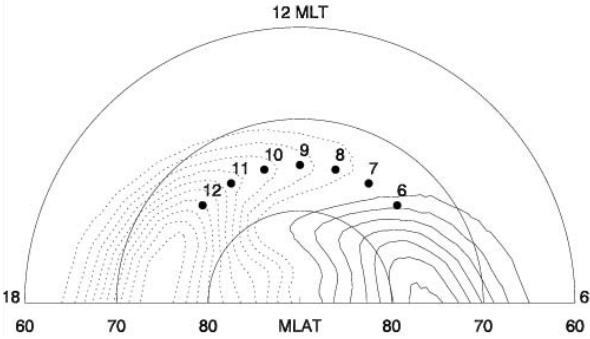
Fig. 3. High latitude electric potential calculated by using the Heppner-Maynard electric convection field model in the condition that IMF By and Bz are negative. The locations of the ESR site during 06:00–12:00 UT are marked by circle dots with numbers in- dicating the universal